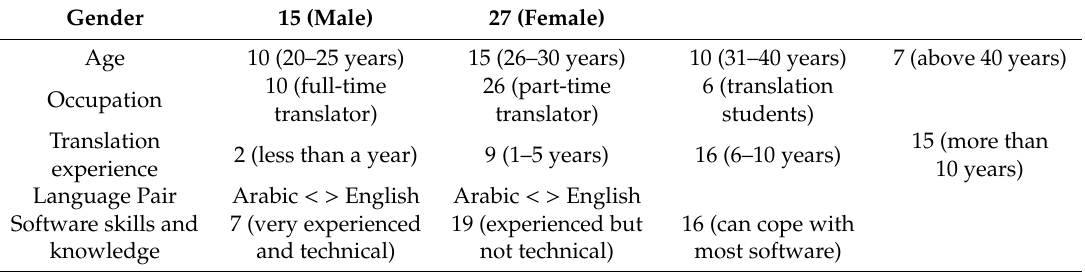
Table 1. Participants’ background